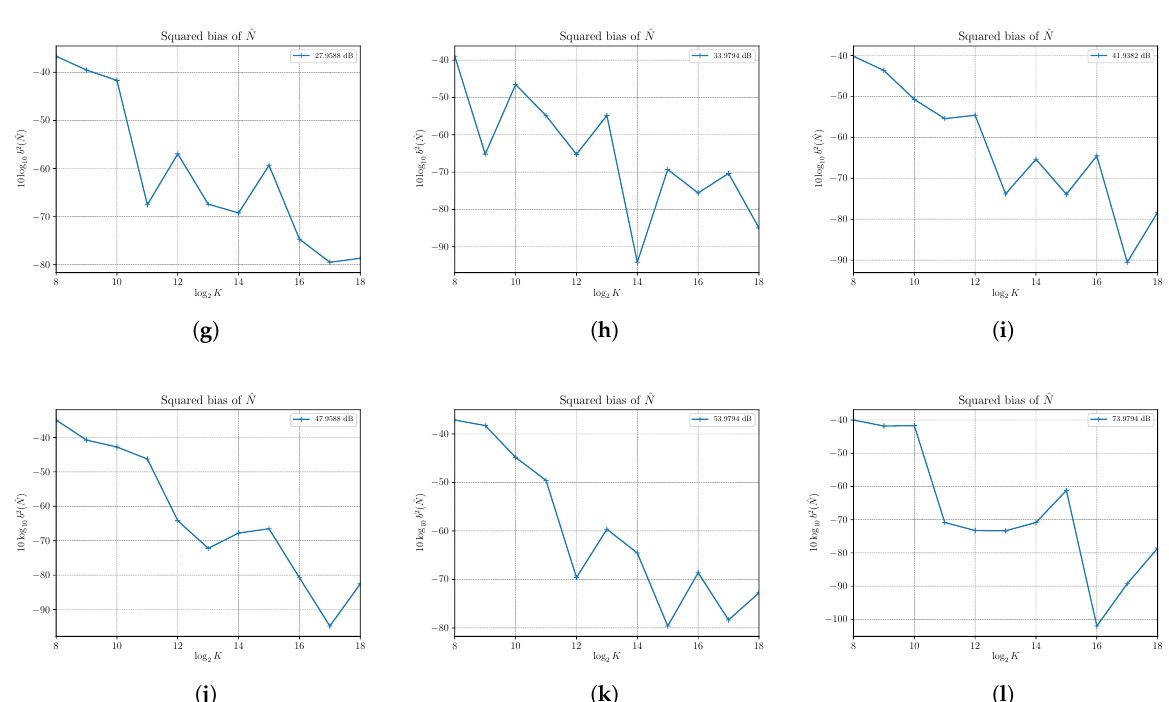
Figure 5. The estimated squared bias b 2 ( ˆ N ) of the noise power estimator ˆ N versus the number of observations K . Each sub figure ( a – l ) shows results for a given nominal value of SNR obtained by changing the signal power S and with noise power N =